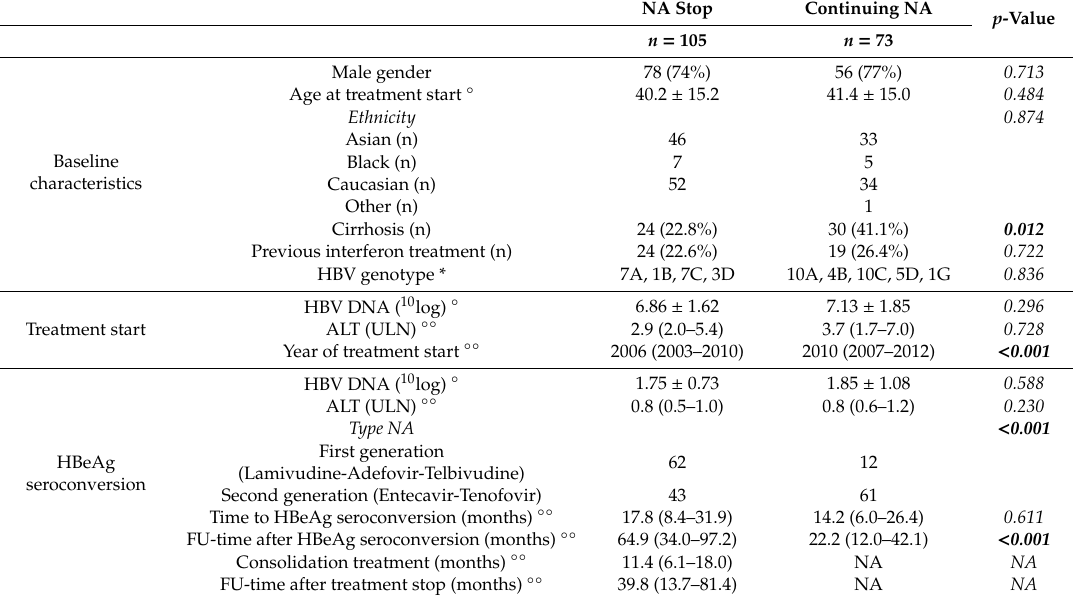
Figure 1. Flowchart of the study cohort according to treatment modality and virologic outcome. NA: Nucleos(t)ide Analogues, HBsAg: Hepatitis B surface antigen, HBeAg: Hepatitis B e antigen, CHB: chronic hepatitis B. Relapse was defined as a single HBV DNA elevation > 2000 IU / mL after treatment Table 1. Patient characteristics according to treatment status after HBeAg seroconversion. *: HBV Genotyping was available in 48 patients, NA: Nucleos(t)ide analog, ULN: Upper limit of normal, ALT: Alanine amino transferase, ◦ : Mean ± SD, ◦◦ : Median (IQR), FU: Follow-up. Significant p -values ( < 0.05) are marked in